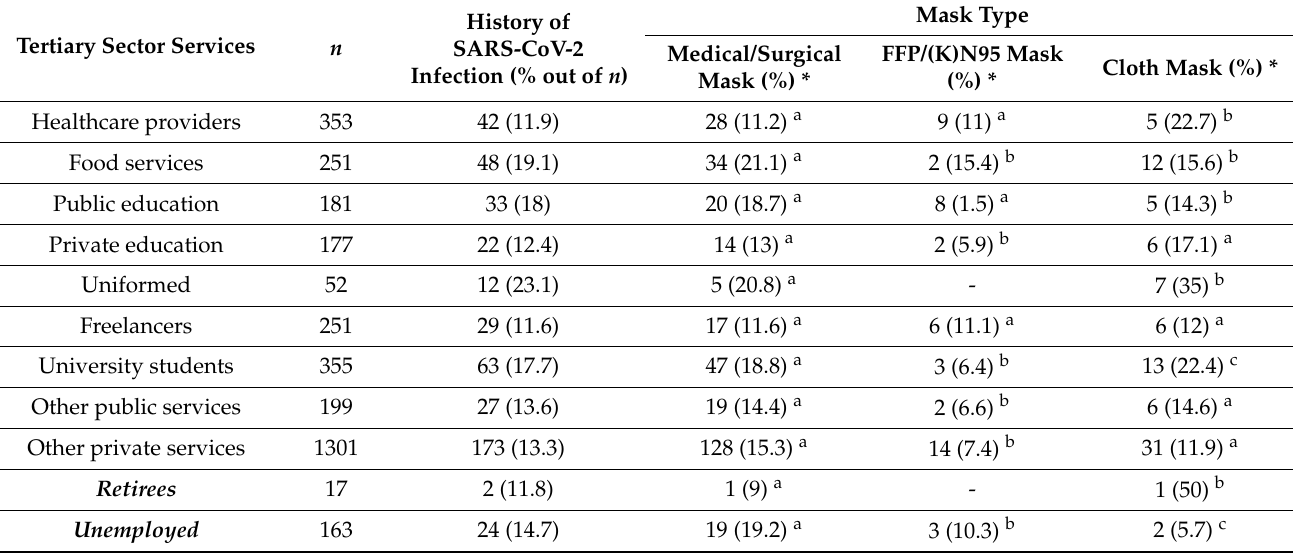
Table 3. History of SARS-CoV-2 infection amongst services by mask